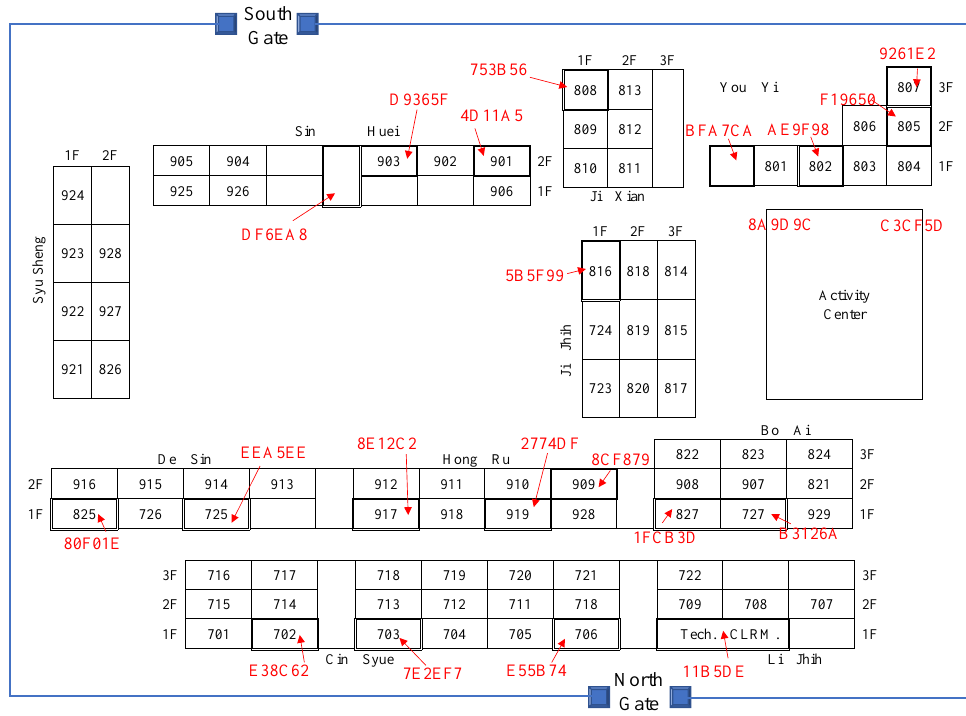
Figure 1. Campus